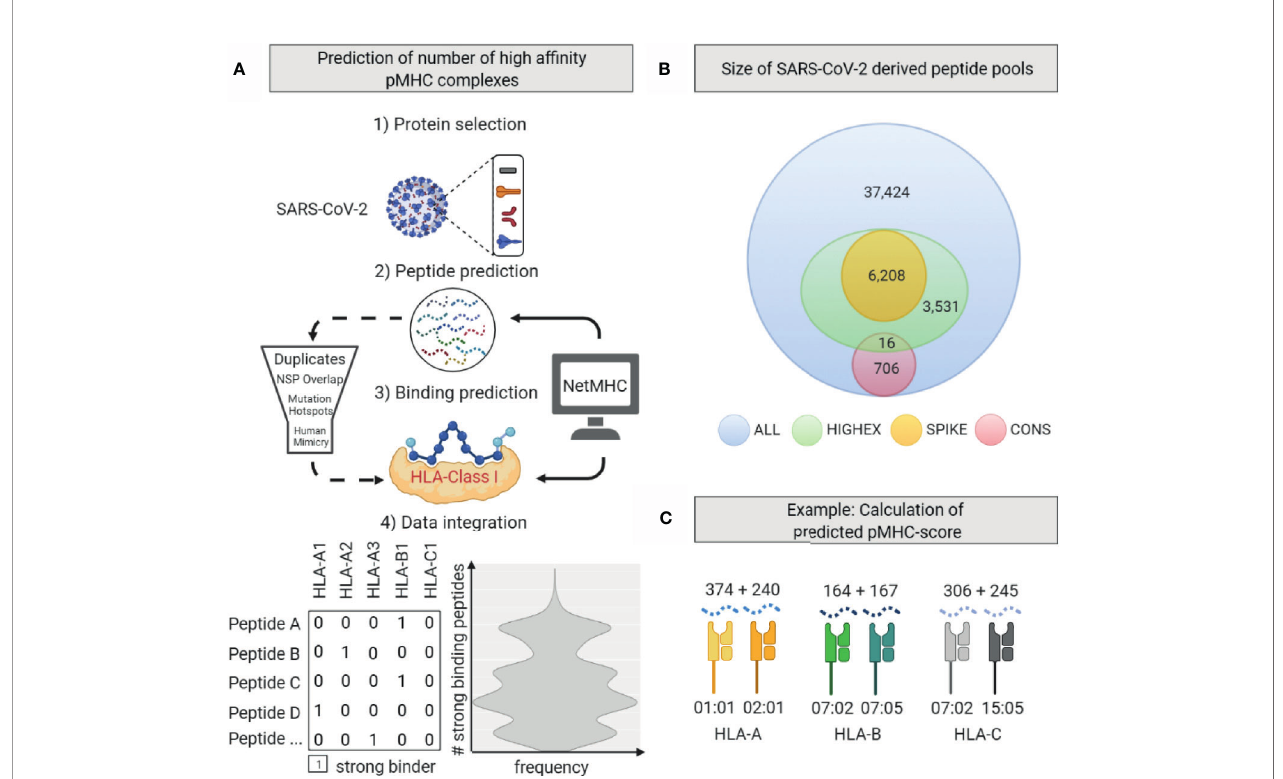
FIGURE 3 | Generation of the predicted peptide-MHC score. (A) Work fl ow for in silico peptide MHC complex (pMHC) prediction based analyses. After selected SARS-CoV-2 proteins were cleaved in silico to produce peptide sequences, NetMHC-software was used to predict strong binding pMHC-combinations. Further processing included peptide fi ltering steps. (B) Numbers of 8 – 12 amino acid (AA) long peptides derived from the total viral proteome (ALL), highly expressed proteins (HIGHEX), the spike glycoprotein (SPIKE), and conserved sequences (CONS) are displayed. (C) Calculation of the predicted pMHC-score shown exemplarily for a given HLA genotype. Numbers of predicted strong binding pMHC complexes from the ALL pool for one exemplary HLA genotype are displayed. The sum of these numbers gives the locus-speci fi c